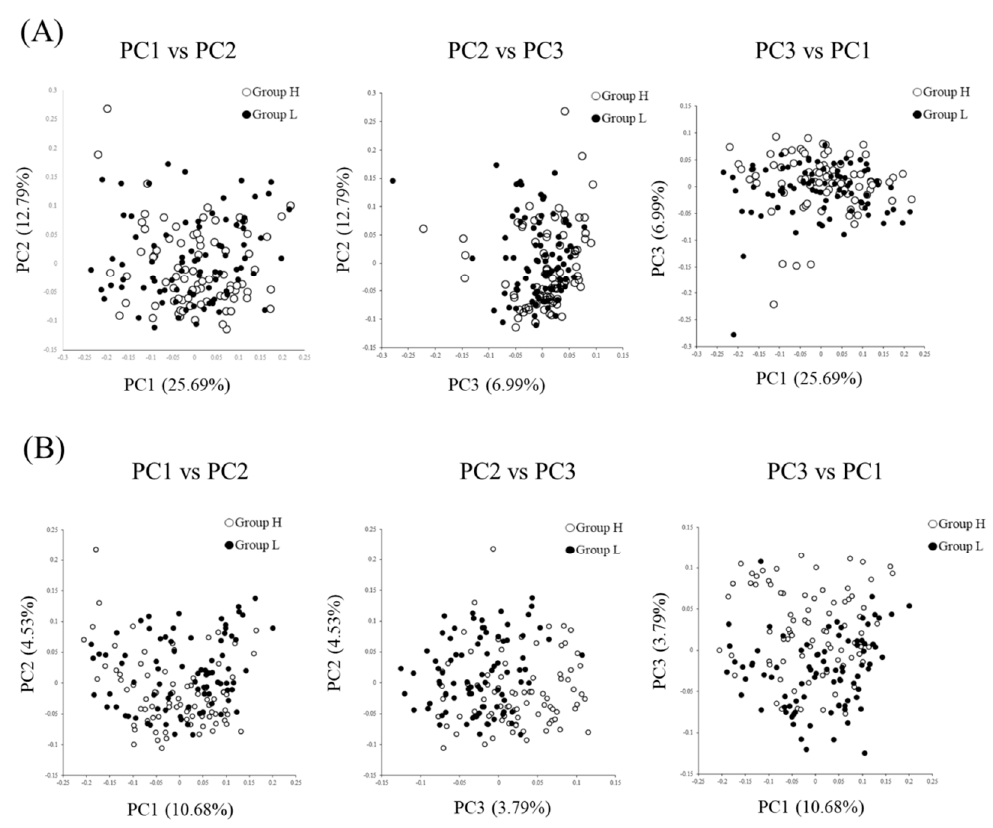
Figure 2. Principal coordinate analysis (PCoA) based on weighted UniFrac ( A ) and unweighted UniFrac ( B ) distances generated from the abundances of the fecal microbiotas. The PERMANOVA analysis indicated that the composition of the fecal microbiotas differed between groups H and L ( P < 0.01.